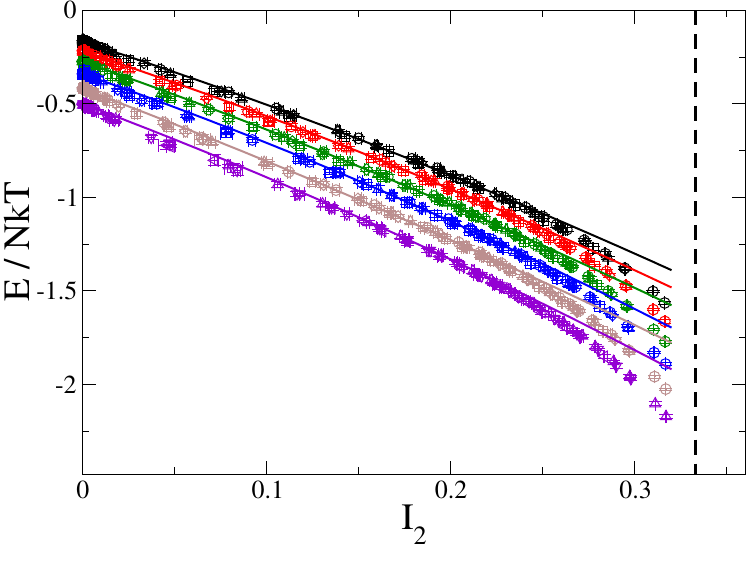
Figure 3. (Color online) Reduced mean internal energy per particle for the Gay–Berne model of [30] as a function of the second tensorial invariant of Q . From top to bottom, temperature decreases as T = 5 . 0 , 4 . 8 , 4 . 6 , 4 . 4 , 4 . 2 . Symbols represent the numerical values from Monte-Carlo simulations in the generalized canonical ensemble, while lines represent the fit to Equation